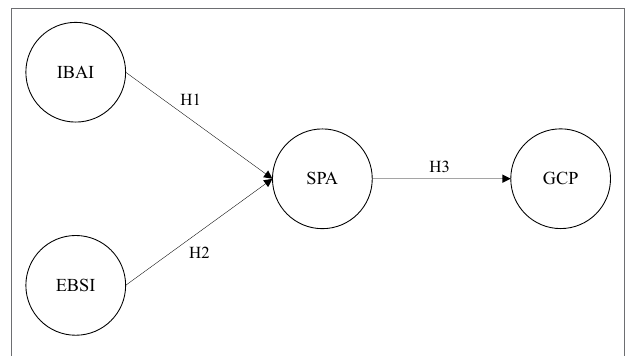
FIGURE 1 | Research model. IBAI, incremental belief of aesthetic intelligence; EBSI, entity belief of spatial intelligence; SPA, spatial performance; and GCP, graphical creativity